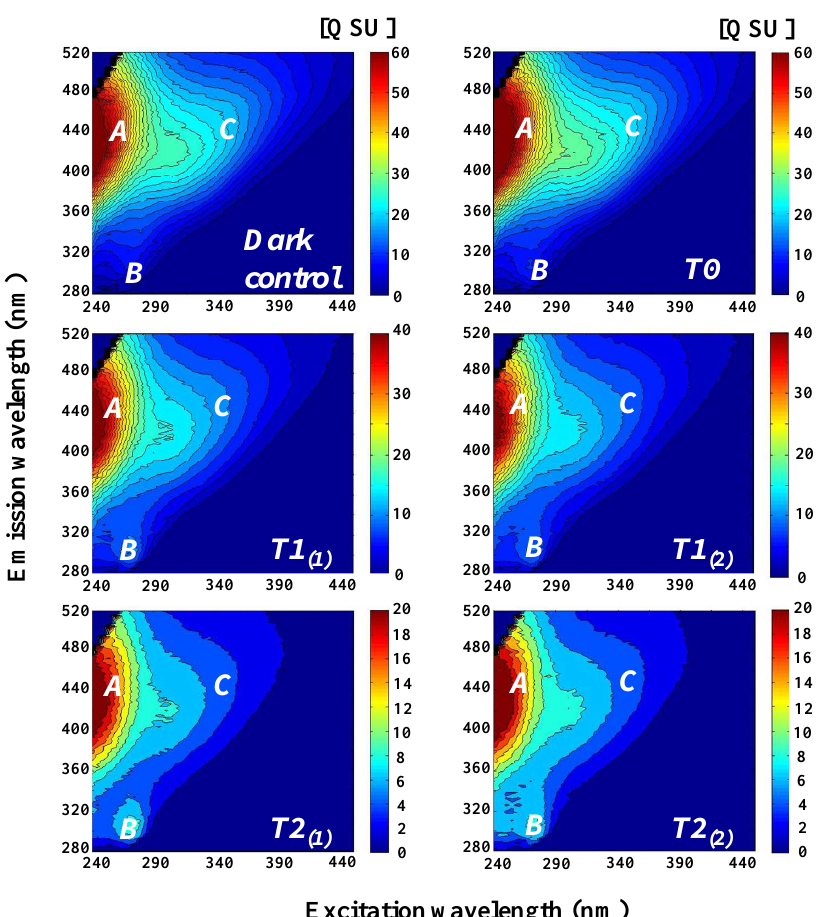
Fig. 5. 2-D EEM contour plots of CDOM (in QSU) collected from Rhˆone River sample, before (T0: upper panel right), and after a full sun exposure of 8 (T1: middle panels) and 20h (T2: bottom panels) using solar simulator. Color-bars’ scales are different. Dark control is indicated in upper panel (left). Corresponding peaks fluorescence intensities are reported on Table